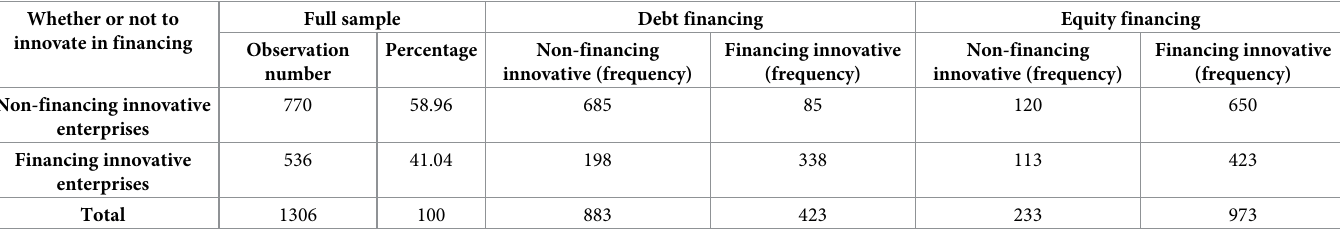
Table 6. Frequencies of financing